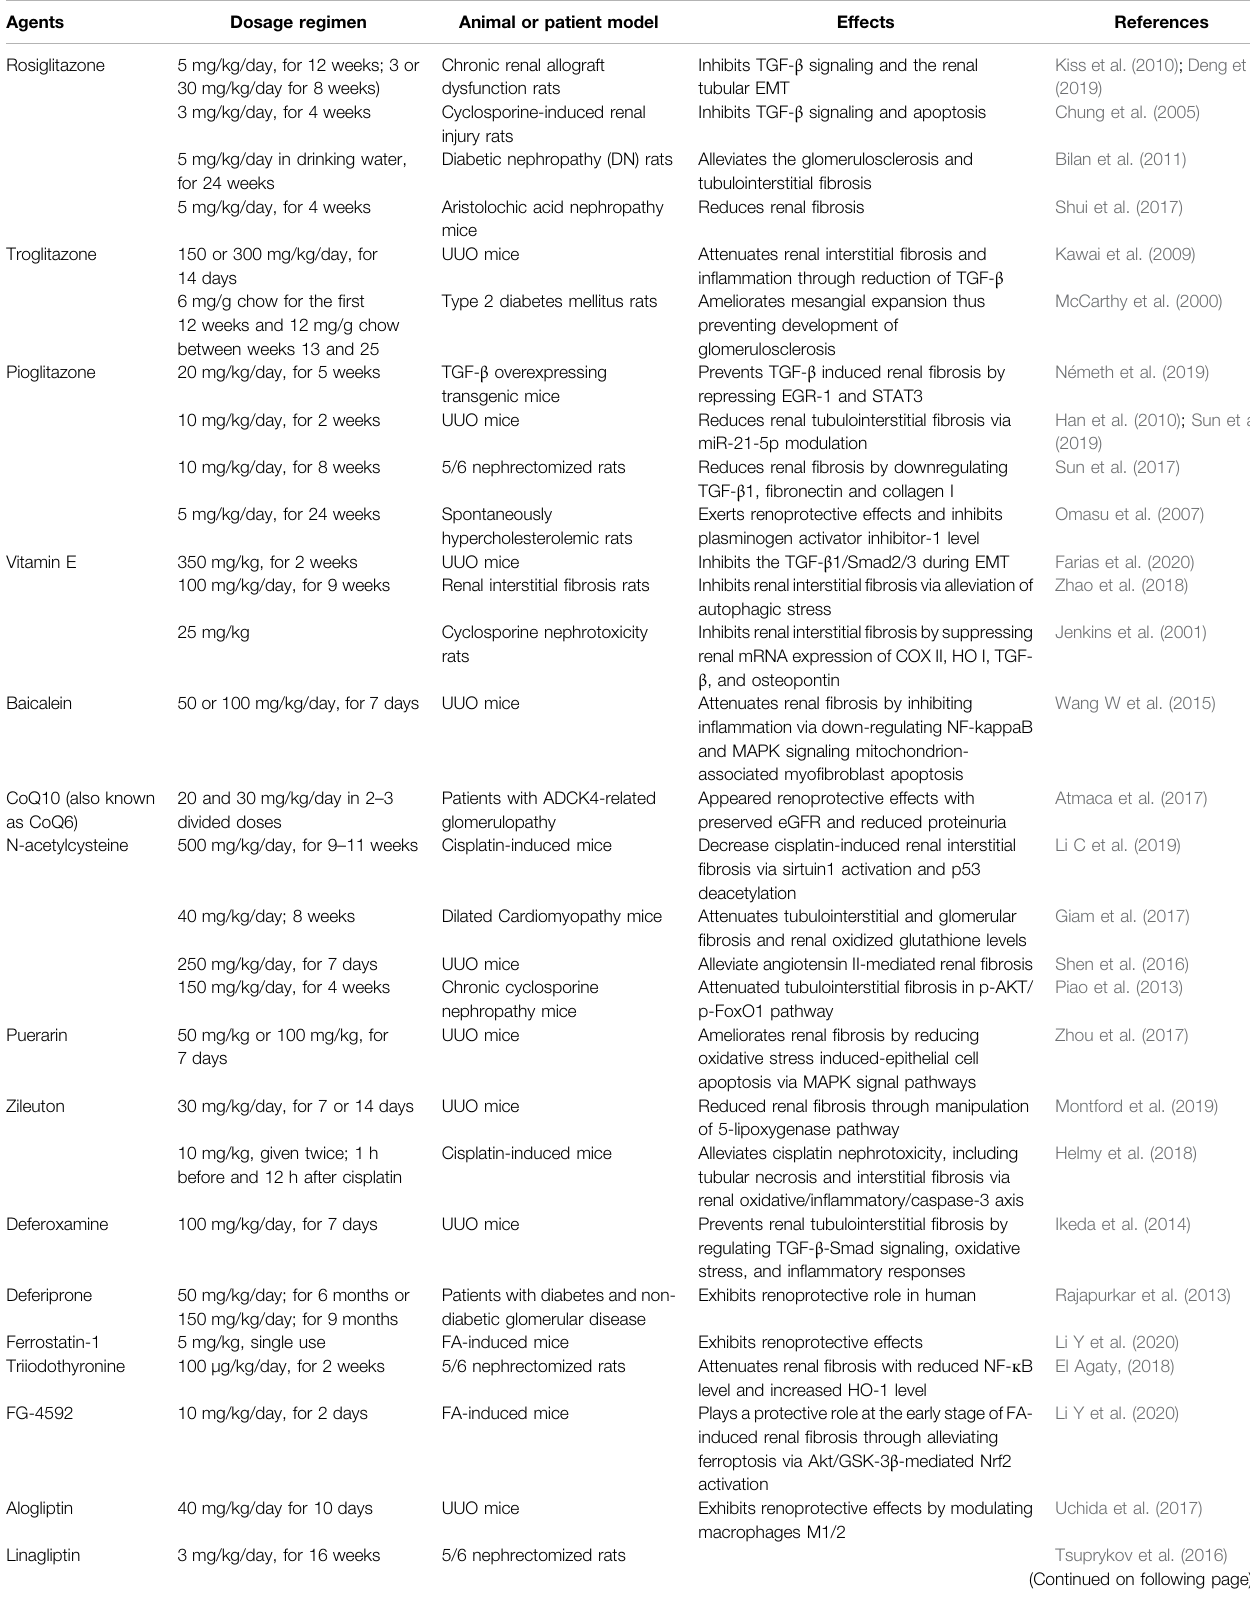
TABLE 2 | Evidence of ferroptosis inhibitors alleviates renal fi brosis in vivo